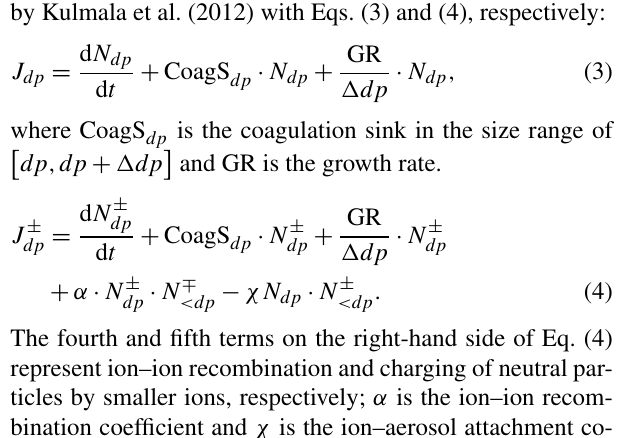
Figure 2. Particle number concentrations in the cluster, nucleation, Aitken and accumulation modes on all the days, NPF event days, haze days and other days. The whiskers include 99.3% of data of every group. Data out of 1.5 times the interquartile range are located outside of the whiskers and considered outliers. The boxes show the median (red line), 25th and 75th percentiles. Data marked with red plus symbols represent outliers.